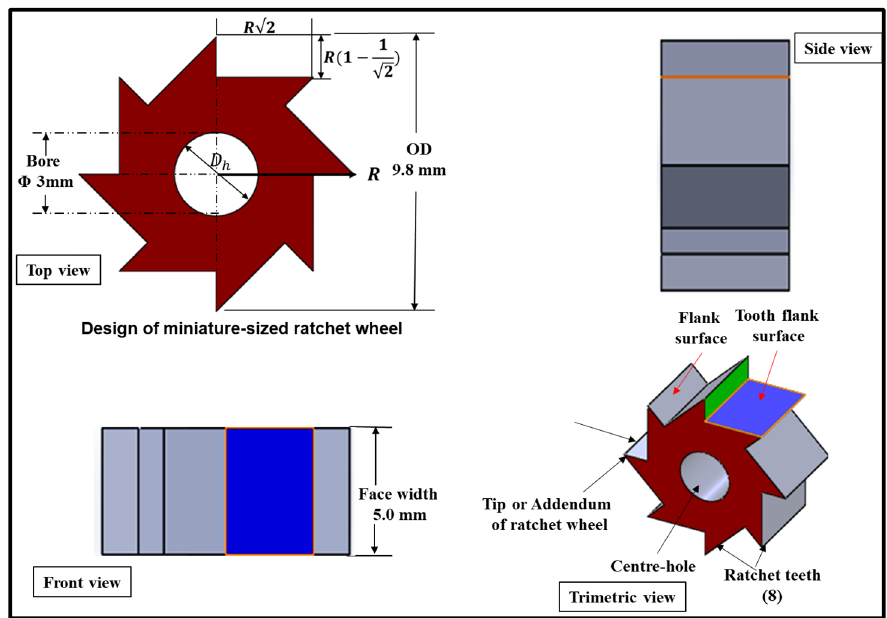
Figure 2. Design and dimensions of the proposed miniature-sized ratchet wheel. Table 1. Details of process parameters, material composition, and ratchet wheel specifications.